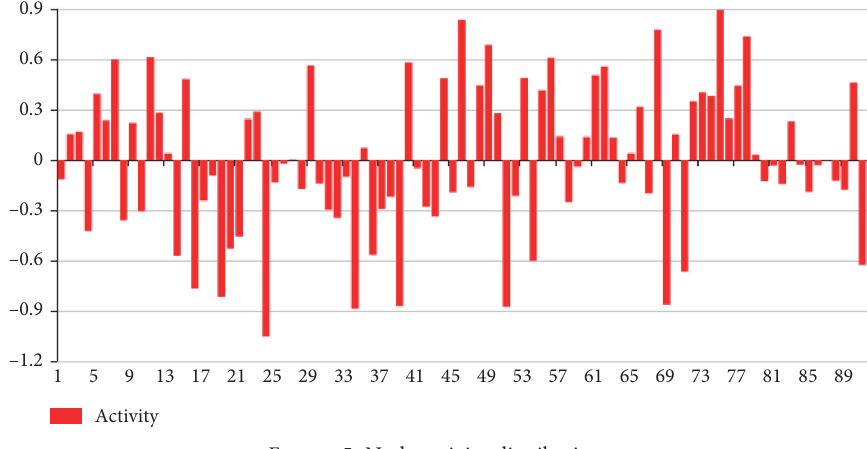
Figure 5: Node activity distribution.